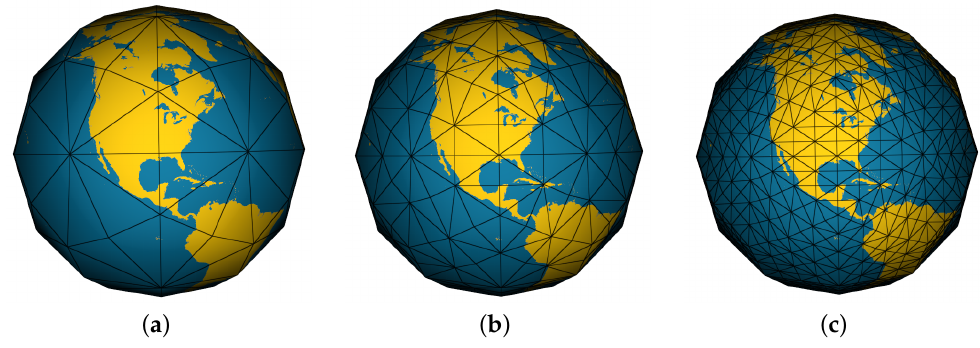
Figure 5. Disdyakis Triacontahedron DGGS at resolution ( a ) 1, ( b ) 2, and ( c ) 3.